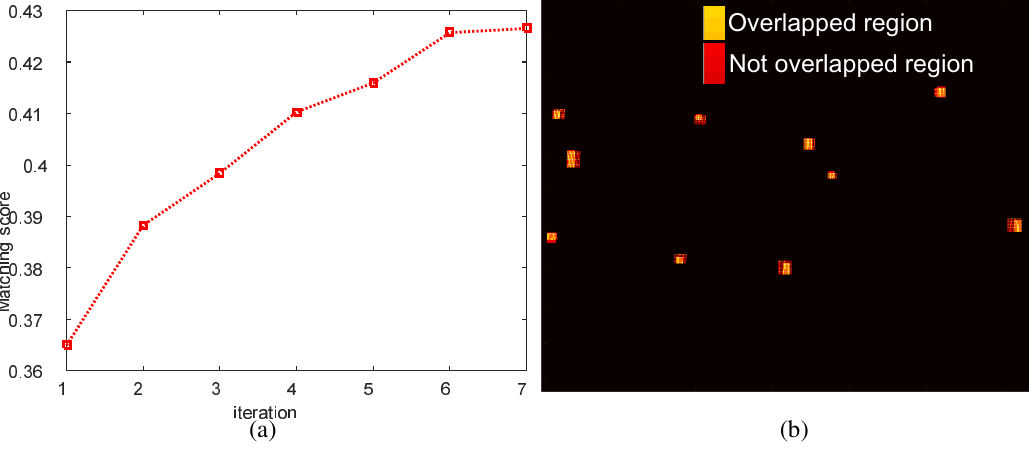
Figure 15. RANSARC-based homography optimization results: ( a ) matching score graph; ( b ) region overlap image using the optimized homography ( H opt